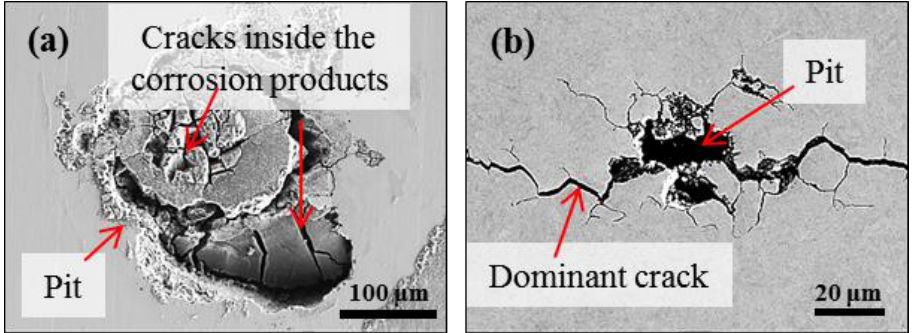
Figure 7. Scanning electron microscopy (SEM) images showing the surface morphologies of corroded specimens A ( a ) and B ( b